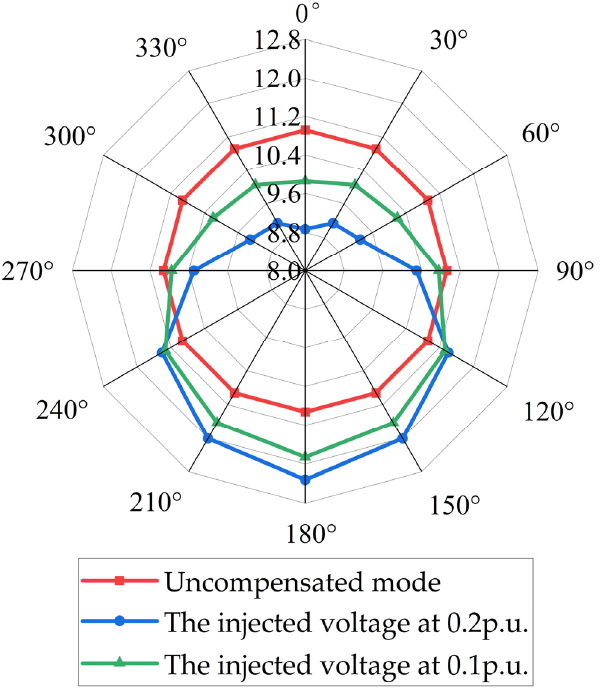
Figure 6. The short-circuit currents for three-phase-to-ground faults.